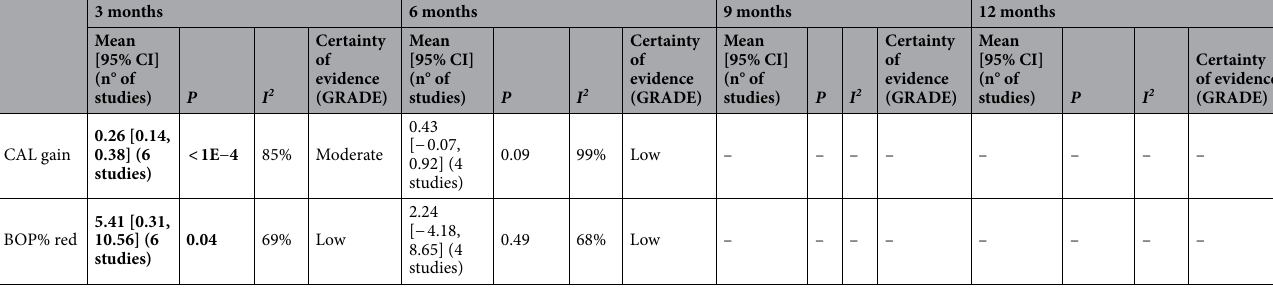
Table 2. Summary of the results of the meta-analysis. Bold means significanlty different (from the statistical point of